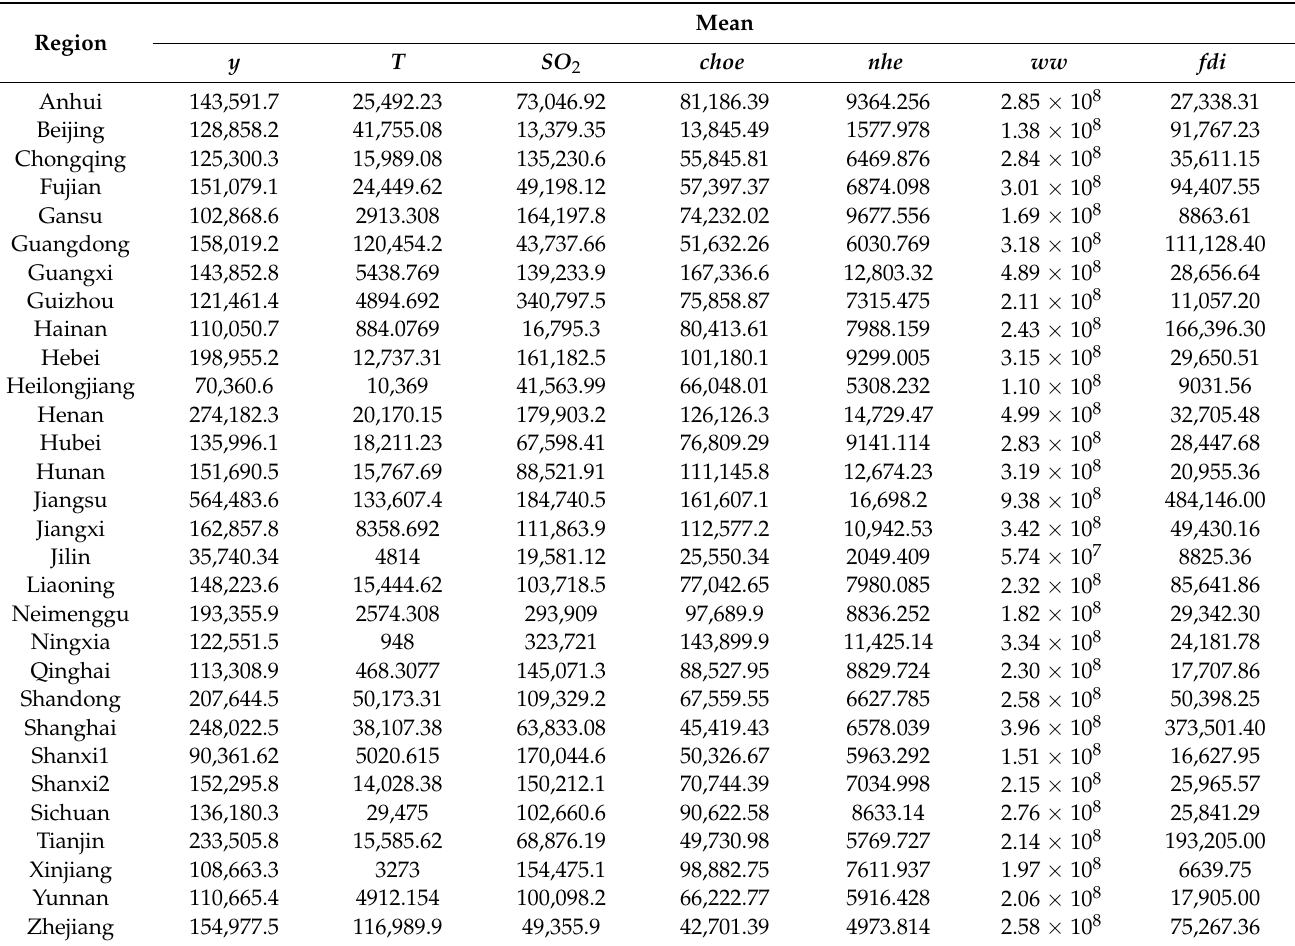
Table 1. Summary statistics (for logarithms of variables) for the period of